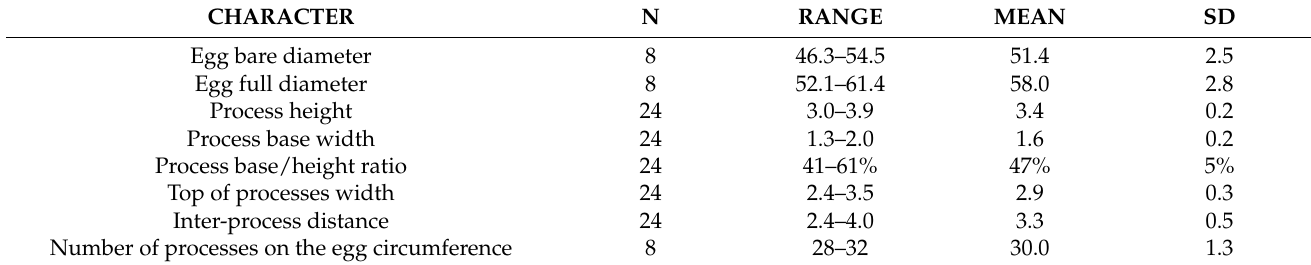
Table 2. Measurements [in µ m] of selected morphological structures of the eggs of Minibiotus intermedius mounted in Hoyer’s medium (N–number of eggs/structures measured, RANGE refers to the smallest and the largest structure among all measured specimens; SD—standard